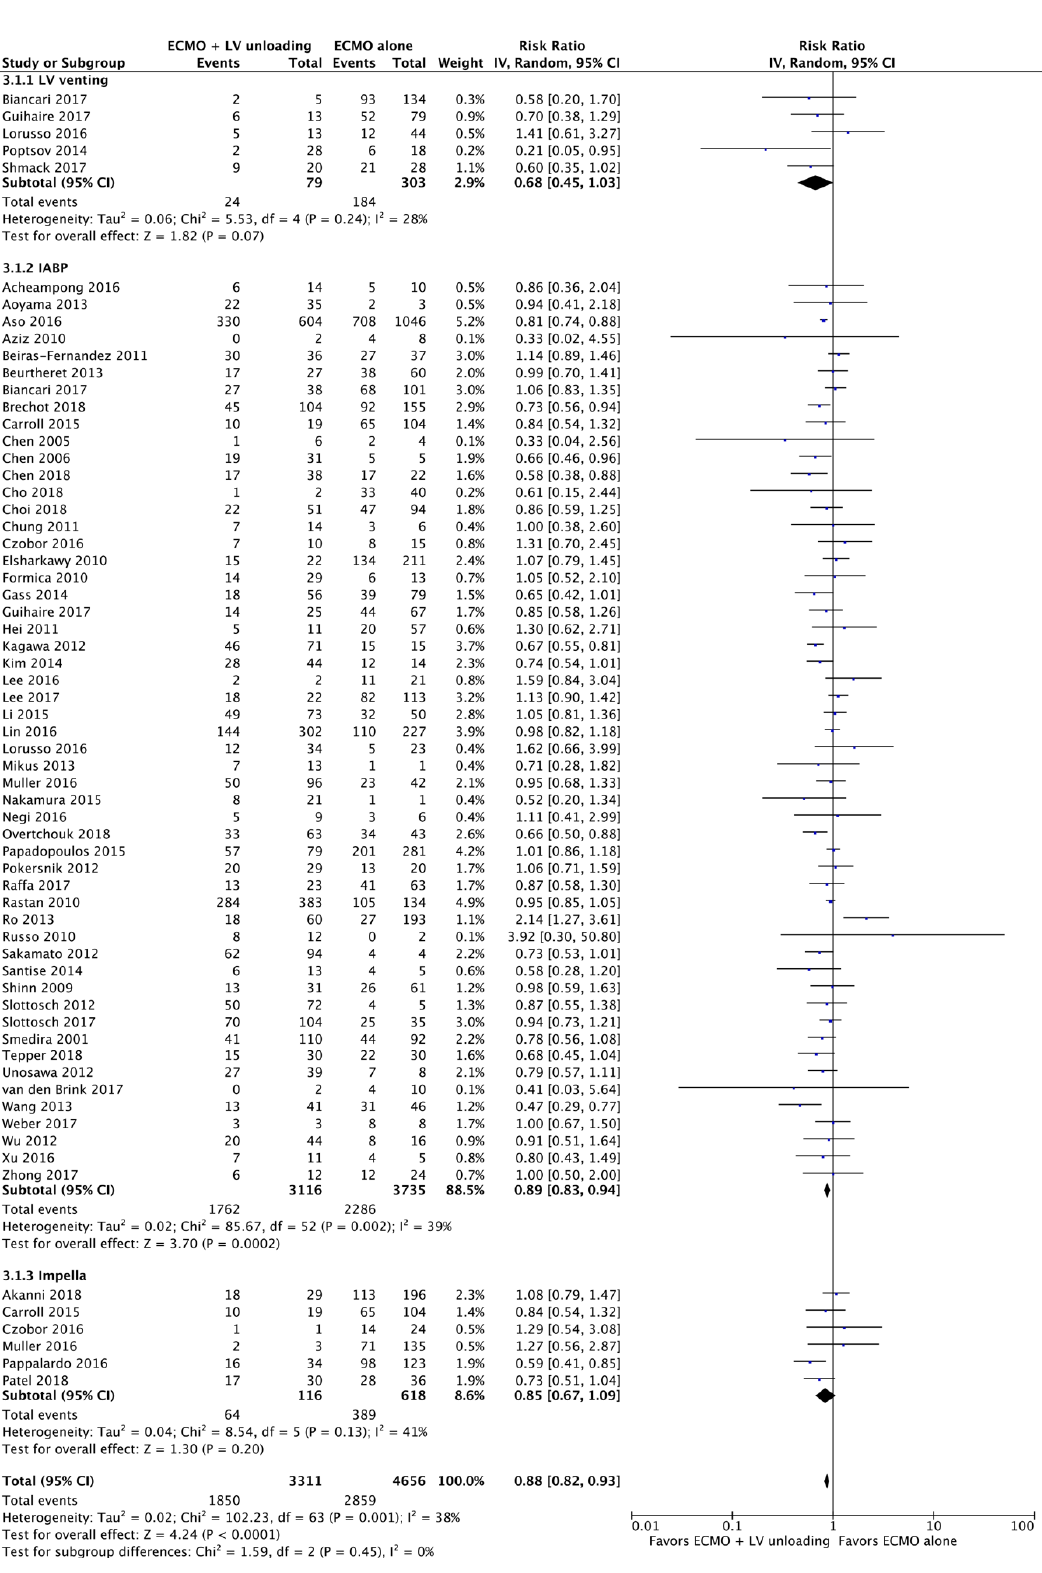
Figure A12. Mortality by device.